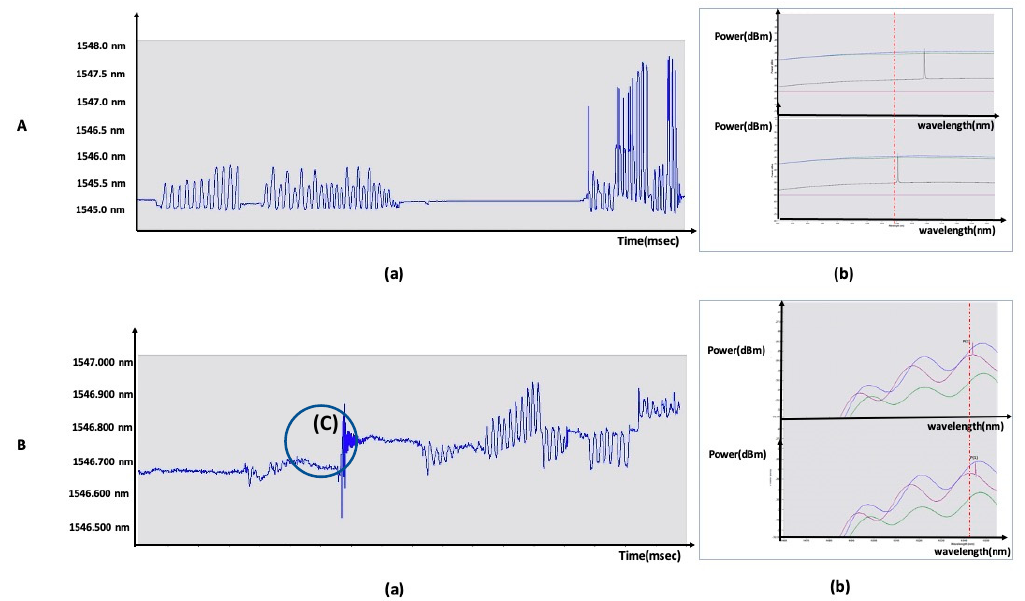
Figure 8. ( A ) (a), (b) time-dependent strain wavelength displacement morphology and spectrum of short-period grating process sensors; ( B ) (a), (b) time-dependent strain wavelength displacement morphology and spectrum of short-period Bragg grating process sensors between long-period gratings.